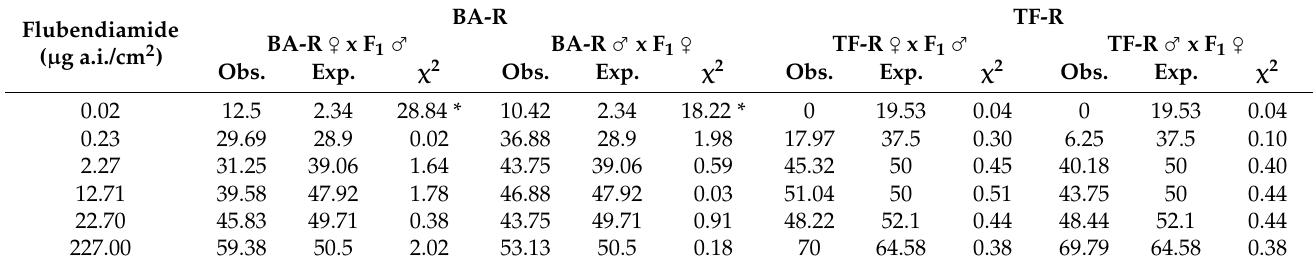
Table 3. Chi-square analysis ( χ 2 ) of the mortality data from the backcrosses between S. frugiperda resistant to flubendiamide (BA-R and TF-R) and F1 progeny of the reciprocal crosses exposed to different concentrations of flubendiamide. Obs, observed; Exp, expected, based on Mendelian inheritance. * Indicates a significant difference ( p < 0.05) between observed and expected